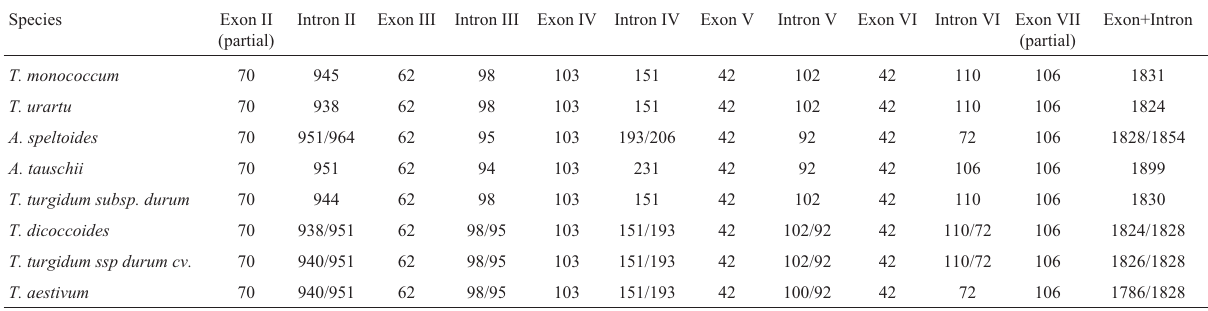
Table 2 - Characteristics of the WAG -2 partial sequences among different species (length of each feature given in bp). Species